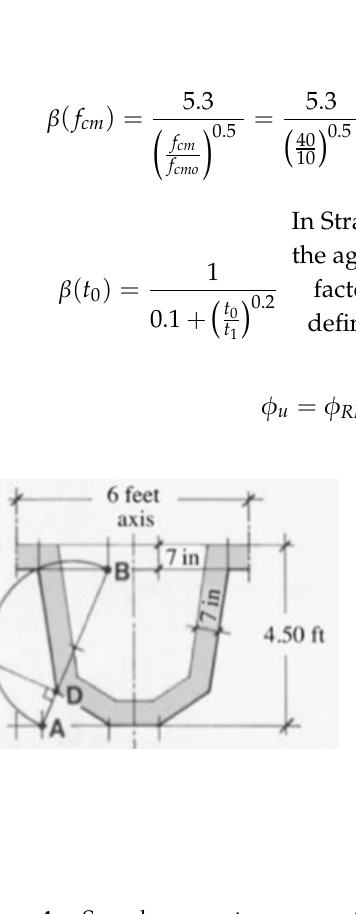
Figure 4. Sample concrete cross-section ( left ) [18] unscaled, calculations for sample concrete section ( right ), conversion factors 1ft = 304.8 mm, 1in = 25.4 mm.